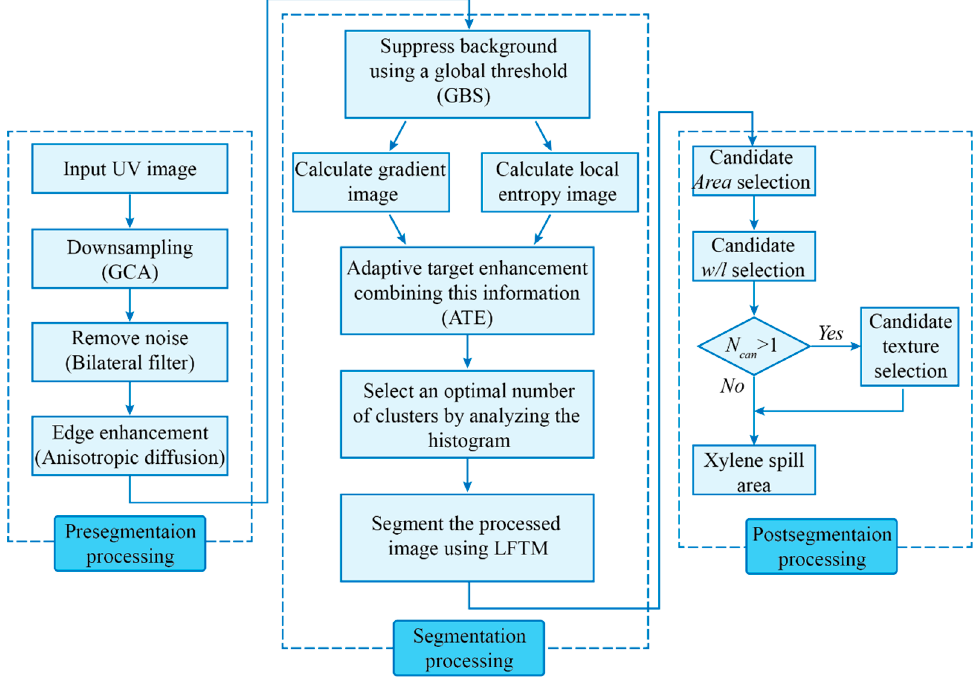
Figure 1. Workflow of the proposed method. Remote Sens. 2018 , 10 , x FOR PEER REVIEW